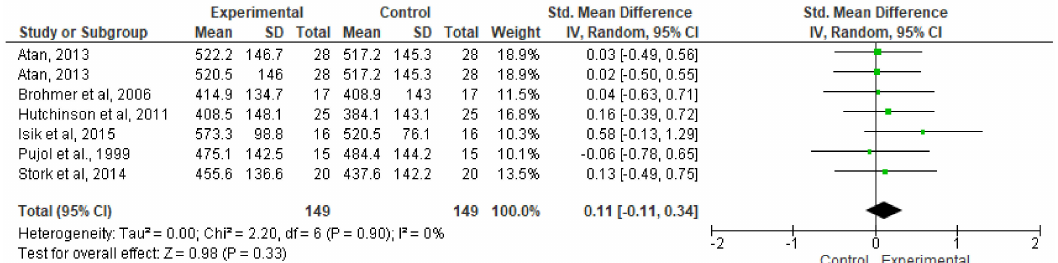
Figure 5. Forest plot comparing the e ff ects of music on absolute mean power performance.